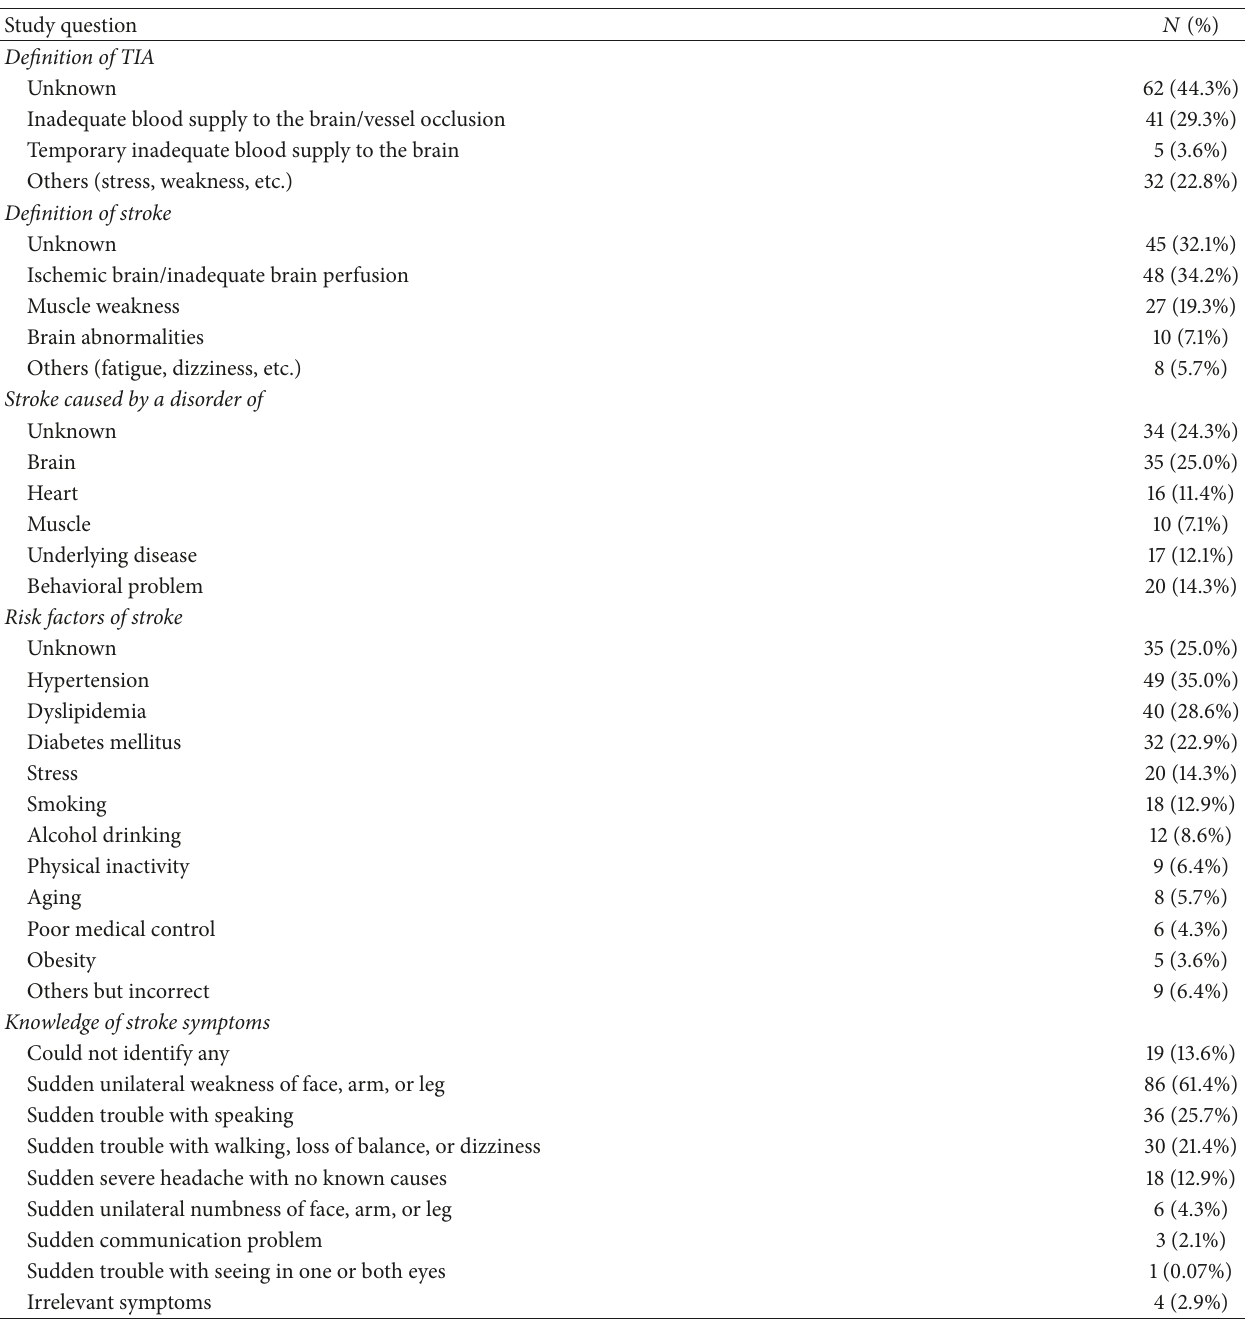
Table 3: Knowledge of stroke risk factors and warning signs (open-ended